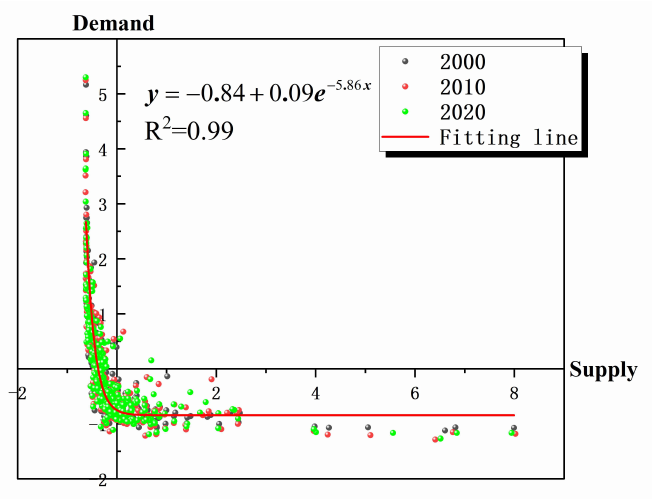
Figure 9. Nonlinear curve fitting of supply and